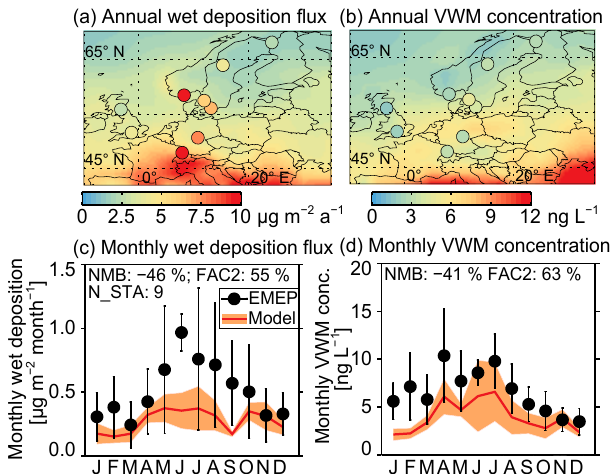
Figure 2. Same as Fig. 1 but for European Monitoring and Evalua- tion Programme (EMEP)